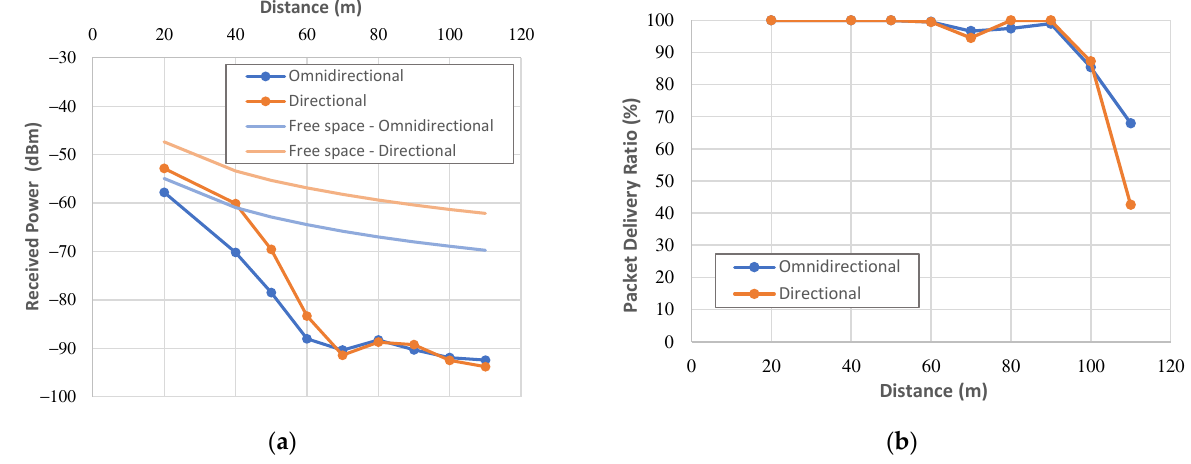
Figure 12. Measurements results of XBee for location 3: ( a ) average RSSI; ( b ) PDR.